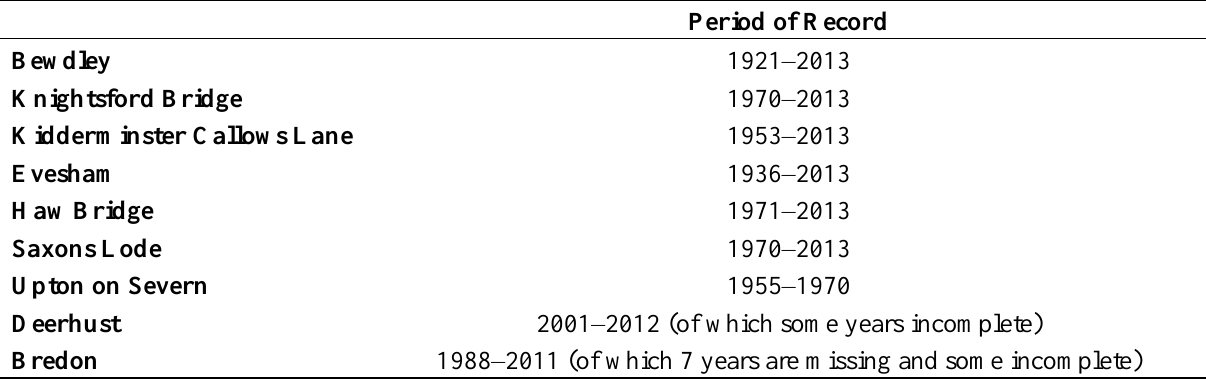
Table 3. Available stations and periods of